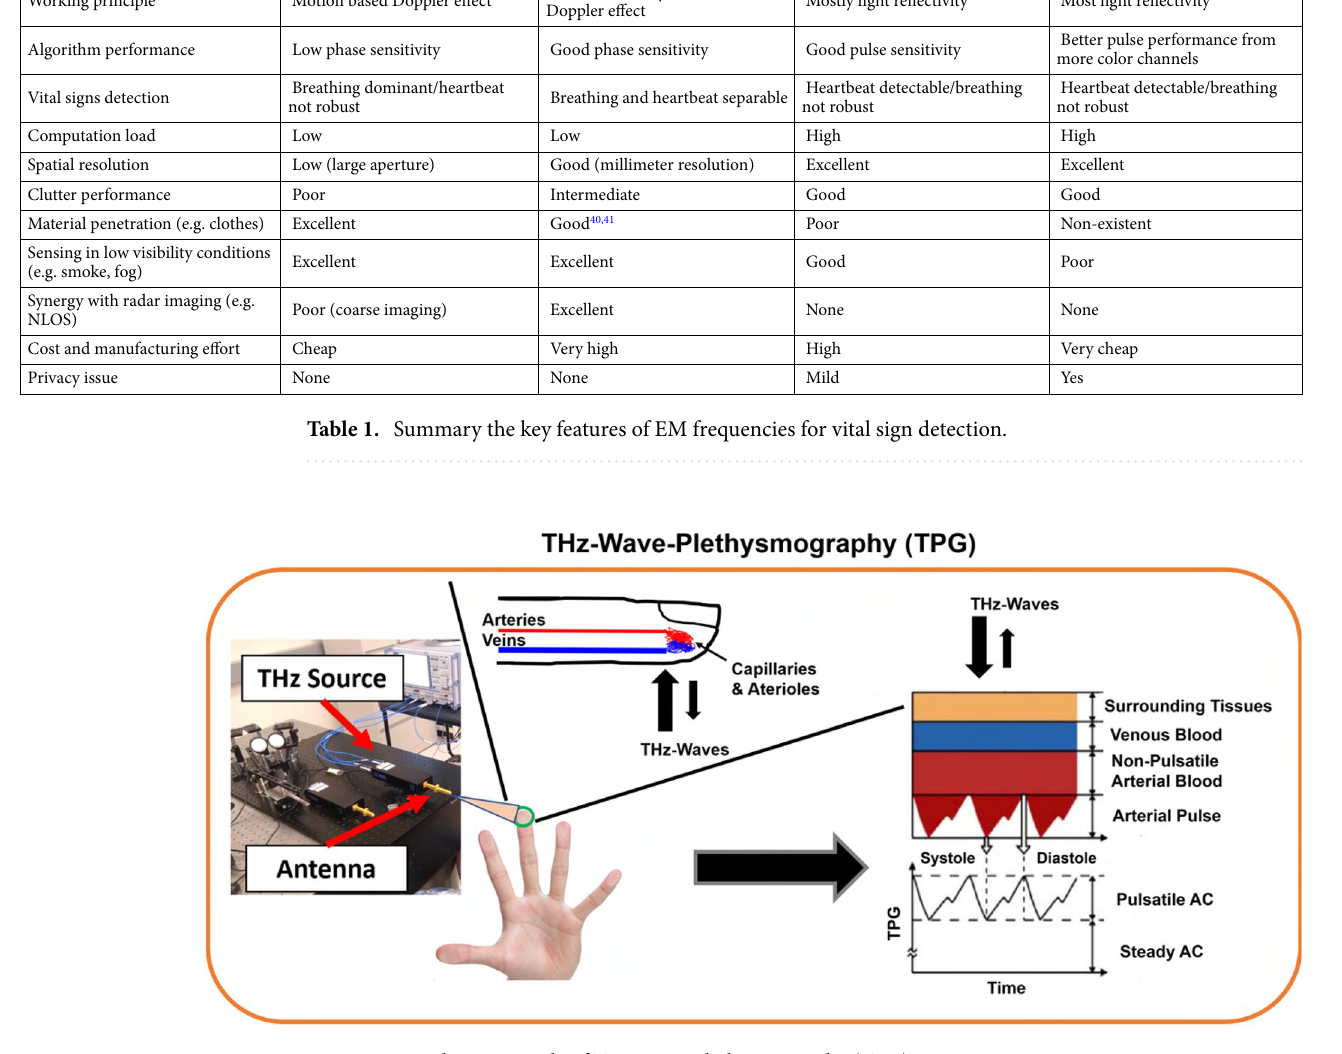
Figure 1. Working principle of THz-wave-plethysmography